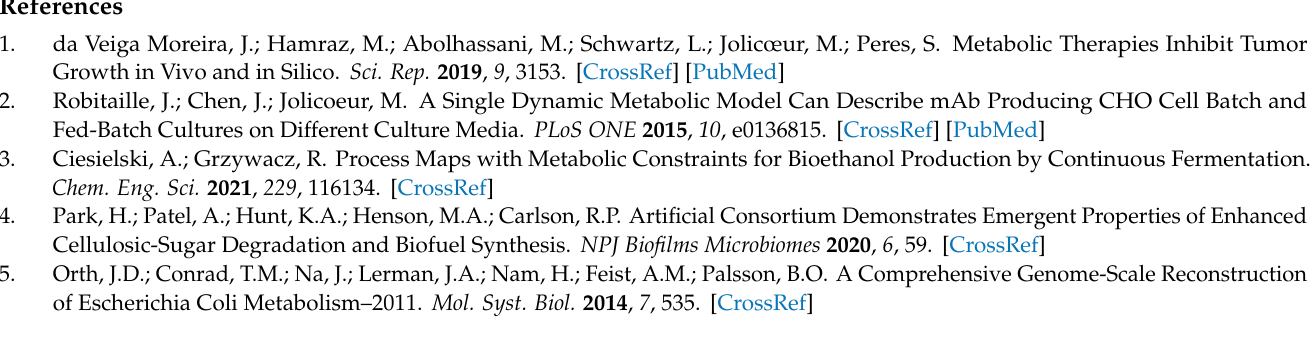
article, Figure S2: Effects of parameter Km u 1 on C